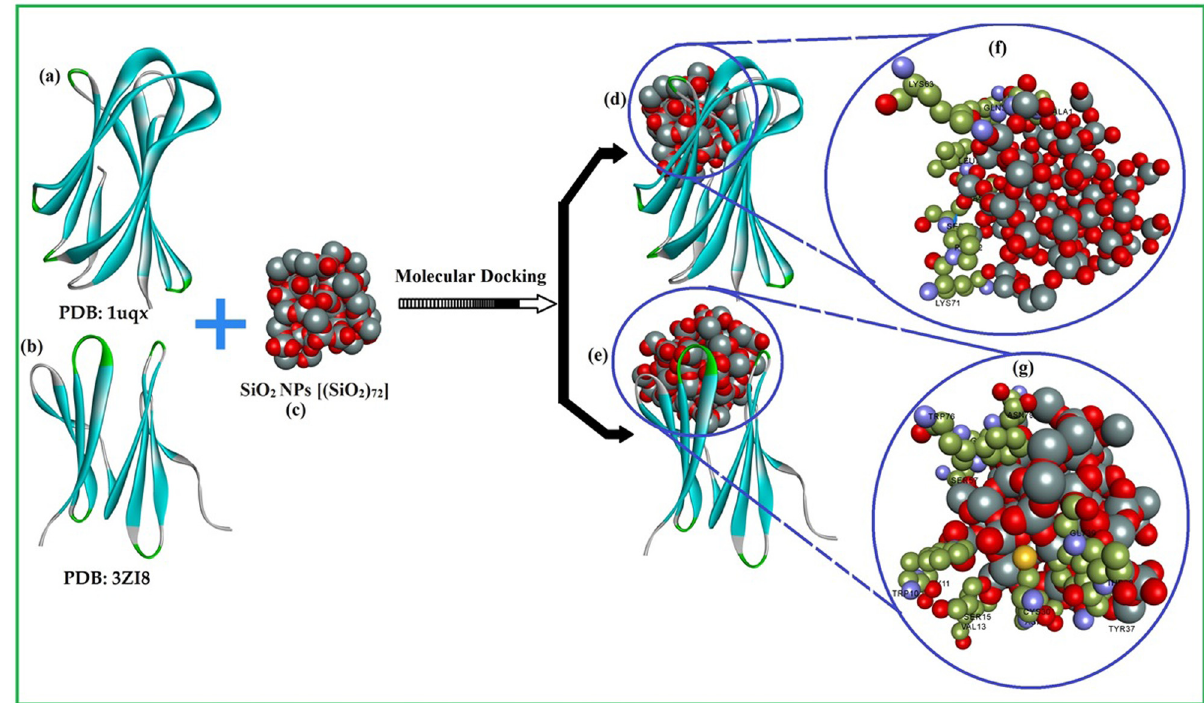
Figure 6: Molecular docking study of NPs ( c ) against two receptors ( a ) PDB: 1uqx and ( b ) PDB: 3zib of R. solanacearum , ( d and e ) demonstrating active sites around NPs and ( f and g ) di ff erent non - bonding amino acid interactions with